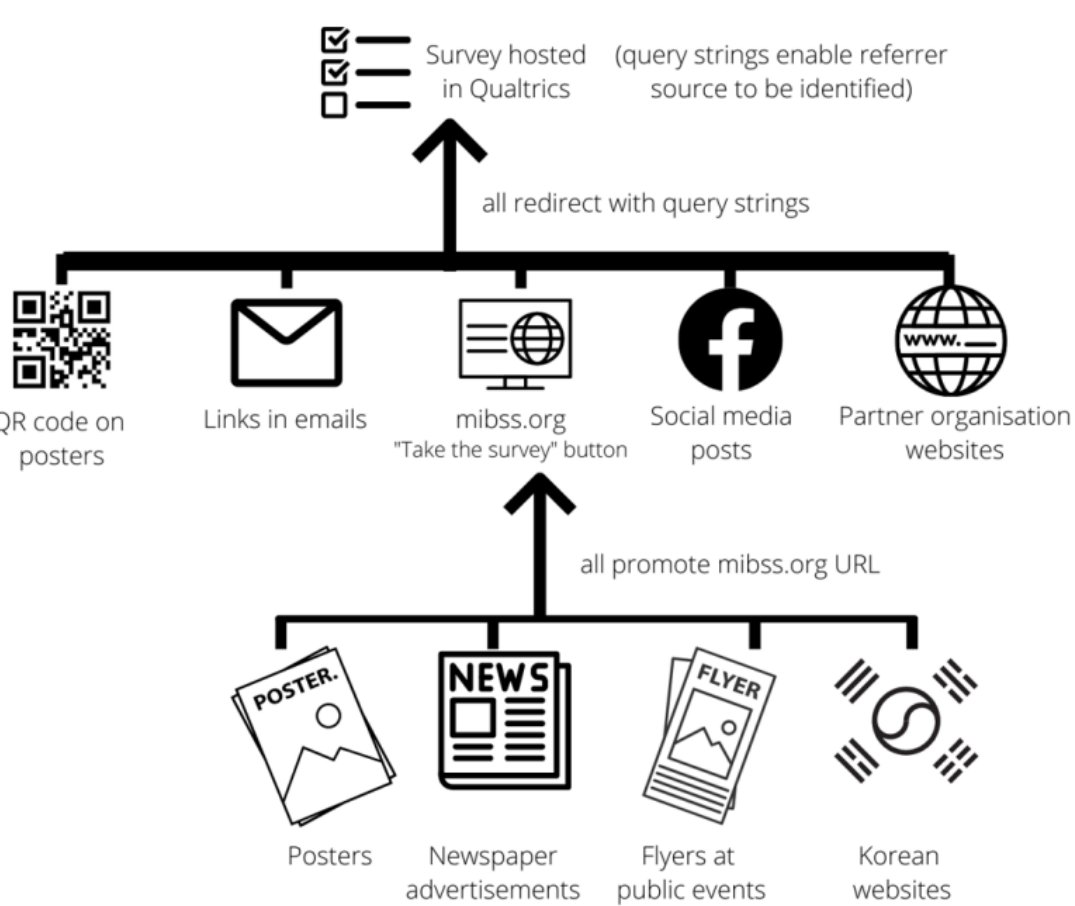
Figure 1. Pathways for online recruitment.